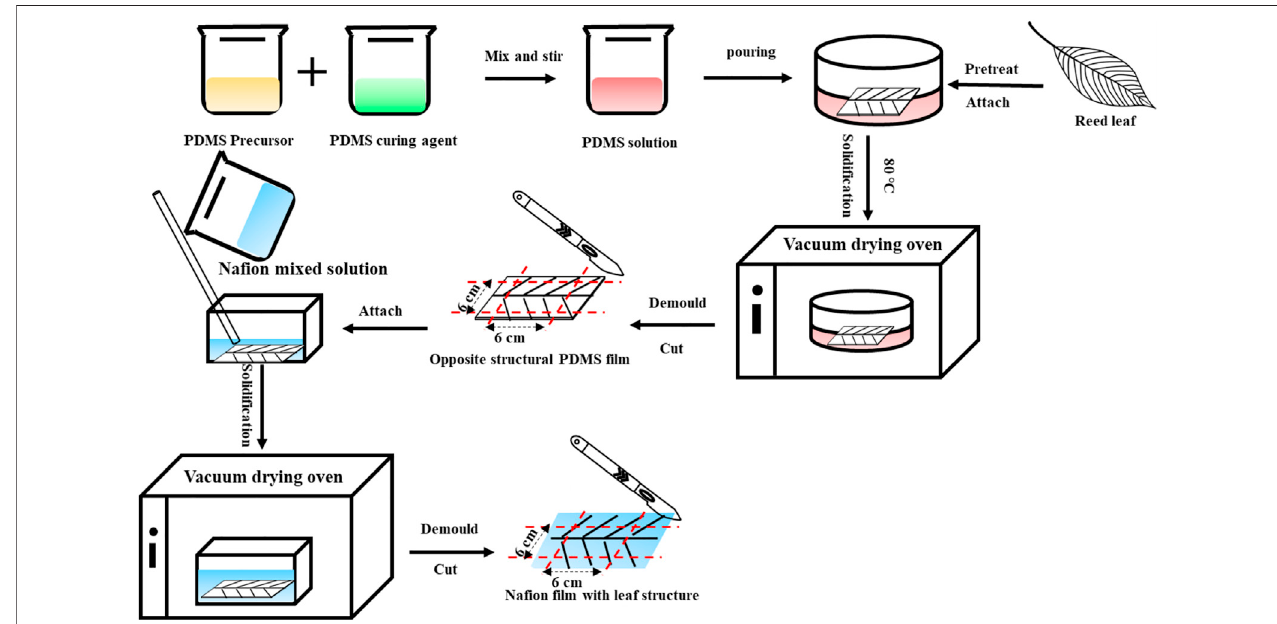
FIGURE 1 | Preparation process of the substrate membrane with biomimetic